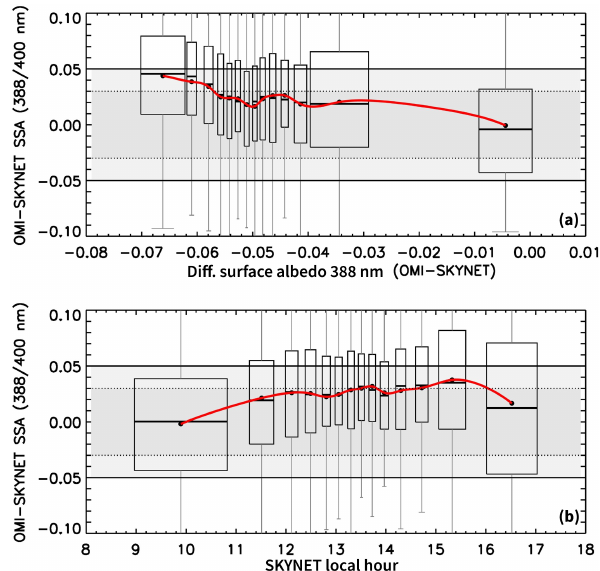
Figure 8. Same as in Fig. 7 but the difference in SSA between OMI and SKYNET is related to (a) the difference in surface albedo as- sumed by the two algorithms and (b) the local measurement hour of